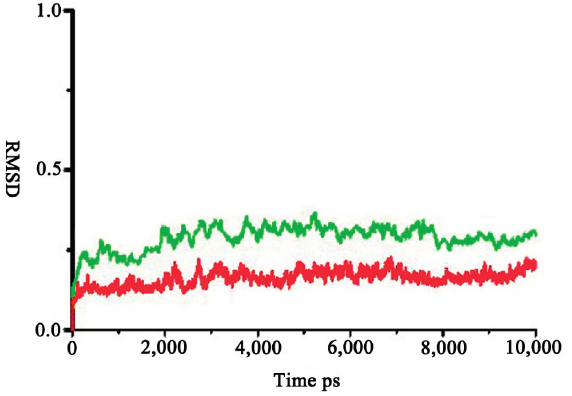
Figure 10. The two RMSD plot during 10 ns simulation (green: zmCP1-D-AMC; red: